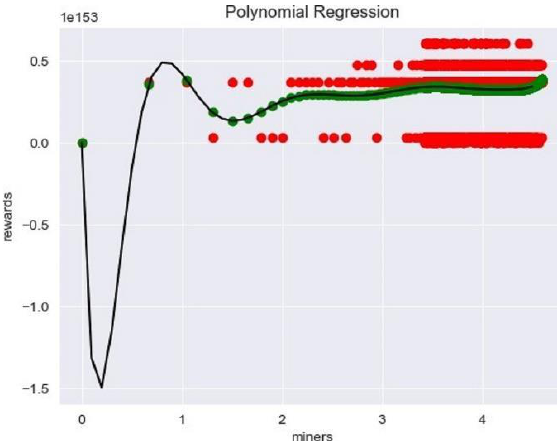
Fig 13. Polynomial Regression for Prediction of next Ethereum block reward.